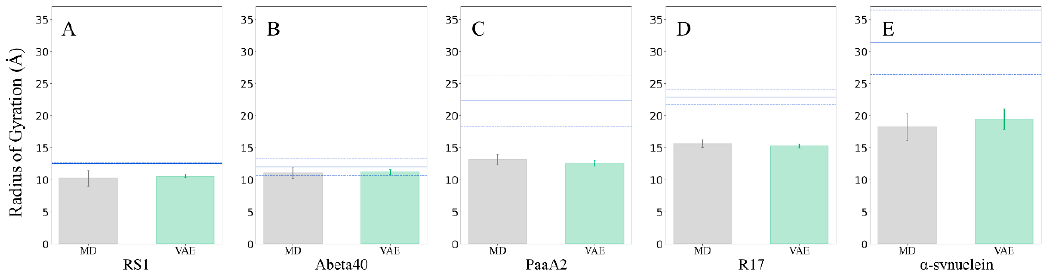
Figure 5. Radius of gyrations for VAE-generated conformations (green) and MD trajectories (grey) compared to experimental data (blue line, dashed lines represent experimental error). ( A ) RS1. ( B ) Abeta40. ( C ) PaaA2. ( D ) R17. ( E ) α -synuclein.